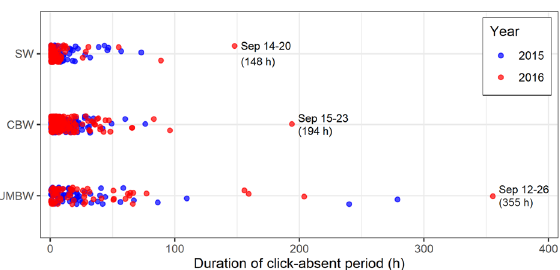
Figure 7. Distributions of click-absent period durations for unidentified Mesoplodont beaked whales (UMBW), Cuvier’s beaked whales (CBW) and sperm whales (SW) at Station 5 in 2015 (blue circles) and 2016 (red circles). Points are randomly jittered on y-axis for visibility. The most extreme outlier values for each species coincided with the CF16 exercise in September 2016 and are labeled with the date range and duration over which clicks were absent from the